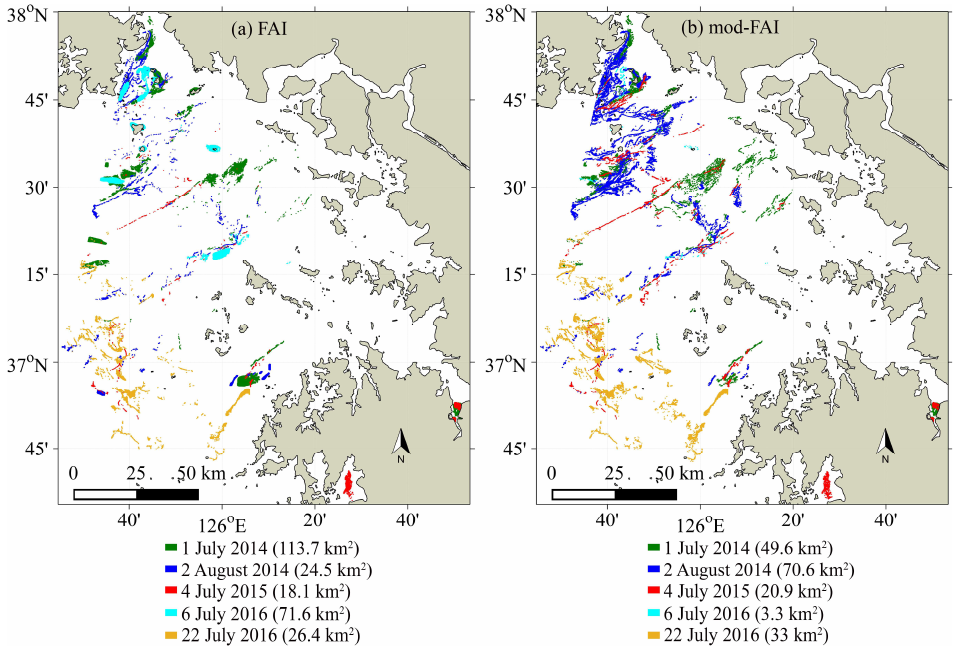
Figure 9. Detection results of macroalgae from Landsat-8 modified FAI images for path/row 116/34. Detected macroalgae pixels are exaggerated in size for better visibility. For the map area refer to the dashed rectangle in Figure 1.